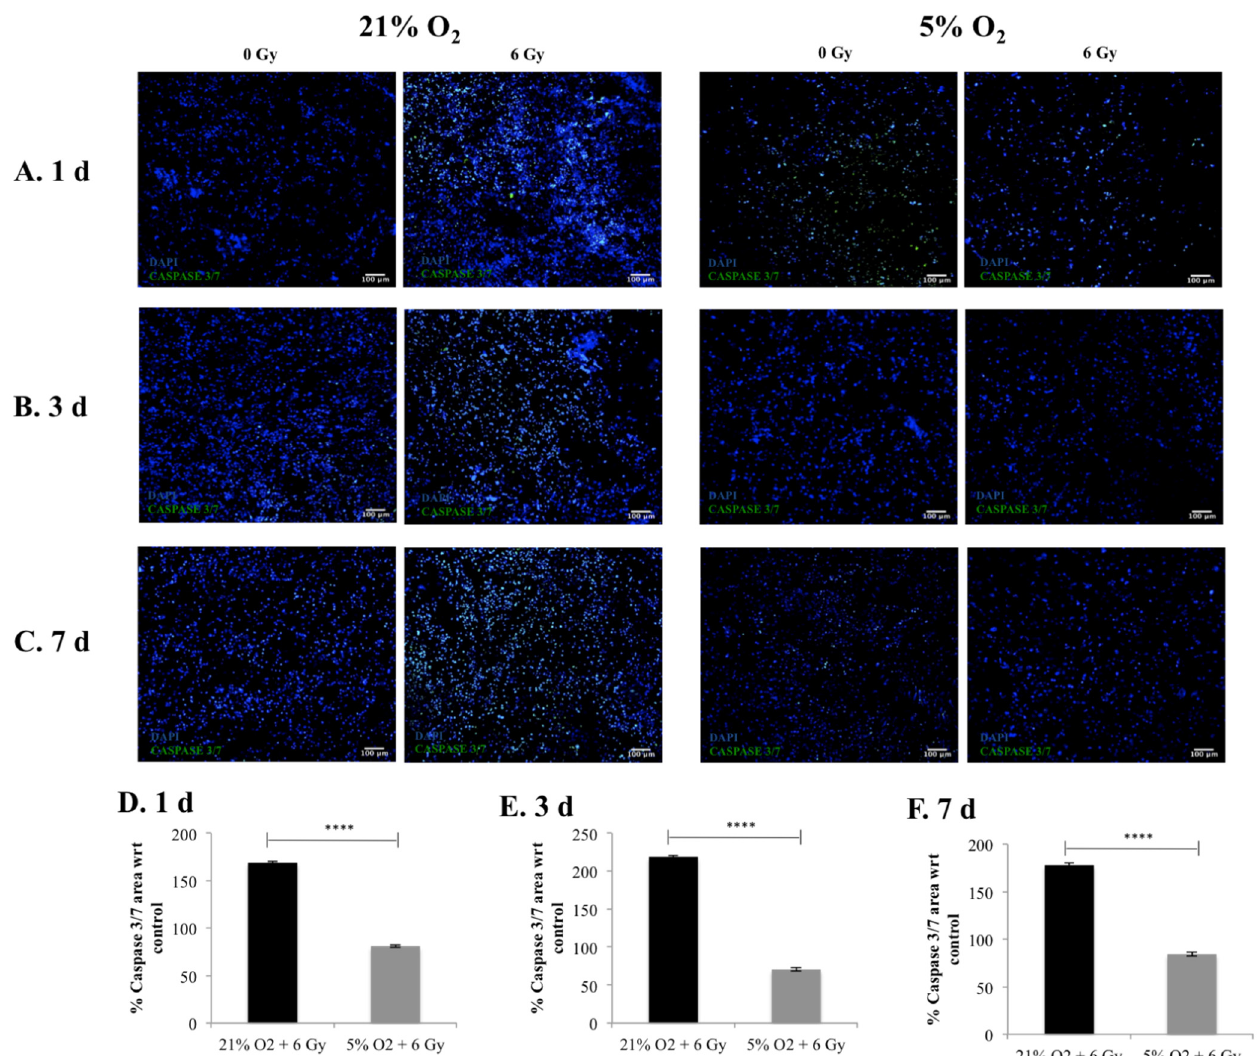
Figure 3. Apoptotic assay (Caspase 3/7) following radiotherapy treatment (6 Gy) in 3D scaffolds for 21% O 2 and 5% O 2 : ( A – C ) Representative images of scaffold sections for Caspase 3/7 (green) and DAPI (blue) staining 1 day, 3 days, and 7 days post-treatment. ( D – F ) Equivalent image analysis based quantification of the percentage of Caspase 3/7 (green) image areas for ( A – C ) with respect to the control (untreated scaffolds). Multiple scaffolds (3), scaffold sections (3), and images (2) were analysed, mean values are presented. (**** = p < 0.0001).